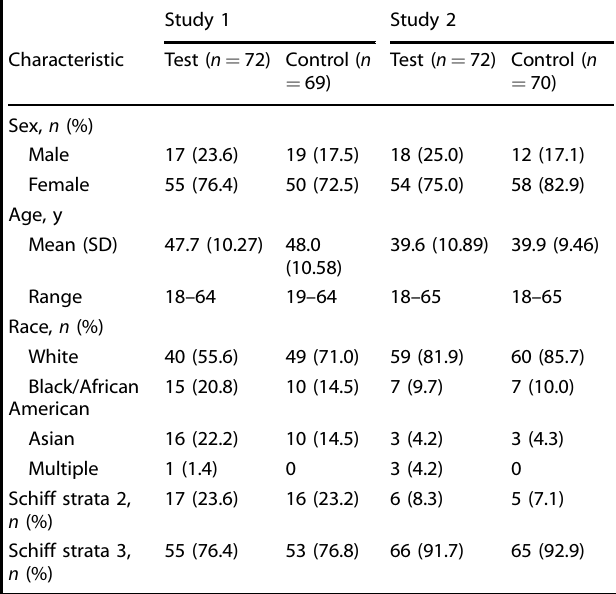
Fig. 1 Participant disposition throughout the study. Table 1. Summary of baseline characteristics (safety